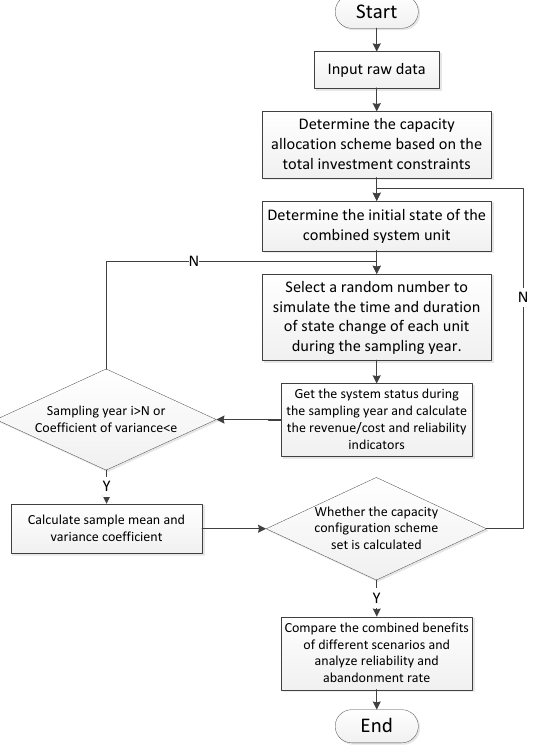
Figure 3. Block diagram of the capacity allocation planning for the hybrid renewable energy system.